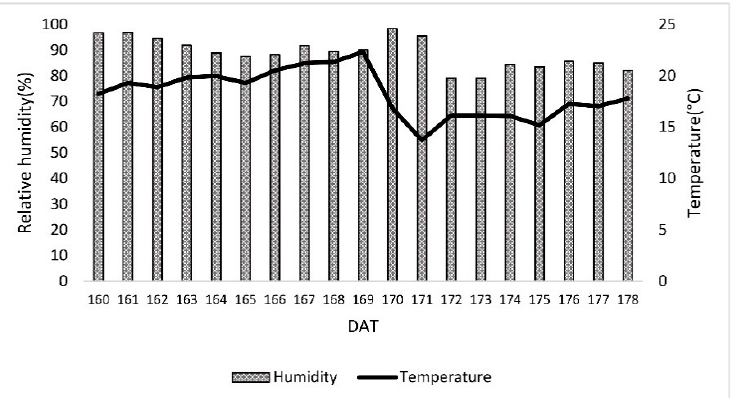
Figure 1. Average humidity and temperature between the 13th and 31st of May 2020 in the seedling nursery of the Department of Forestry Science of the Faculty of Agronomic Sciences (FCA) (DAT: days after transplanting).